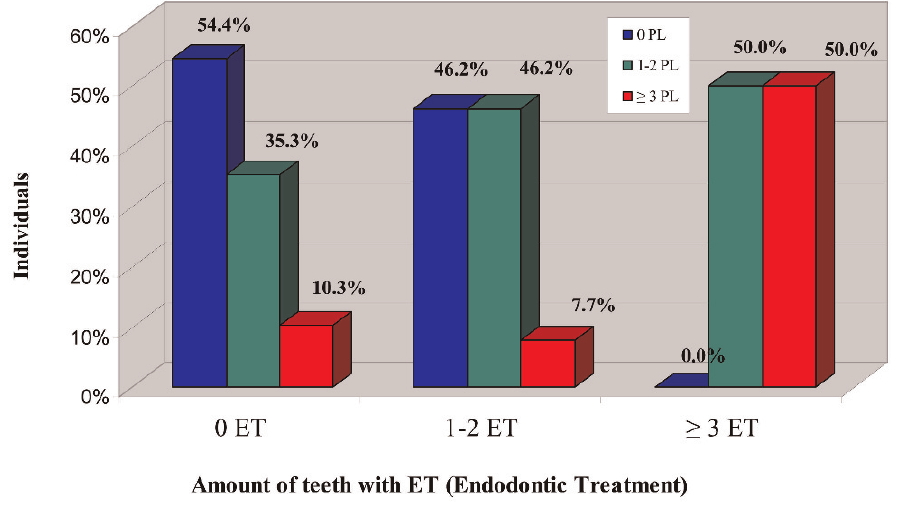
Figure 1 - Bivariate analysis between the number of teeth that underwent endodontic treatment (ET) (categorized as 0, 1-2 and $ 3) and the frequency (%) of individuals with periradicular lesions (PL) (categorized as 0, 1-2 and $ 3) ( p =0.018; Fisher’s exact test).